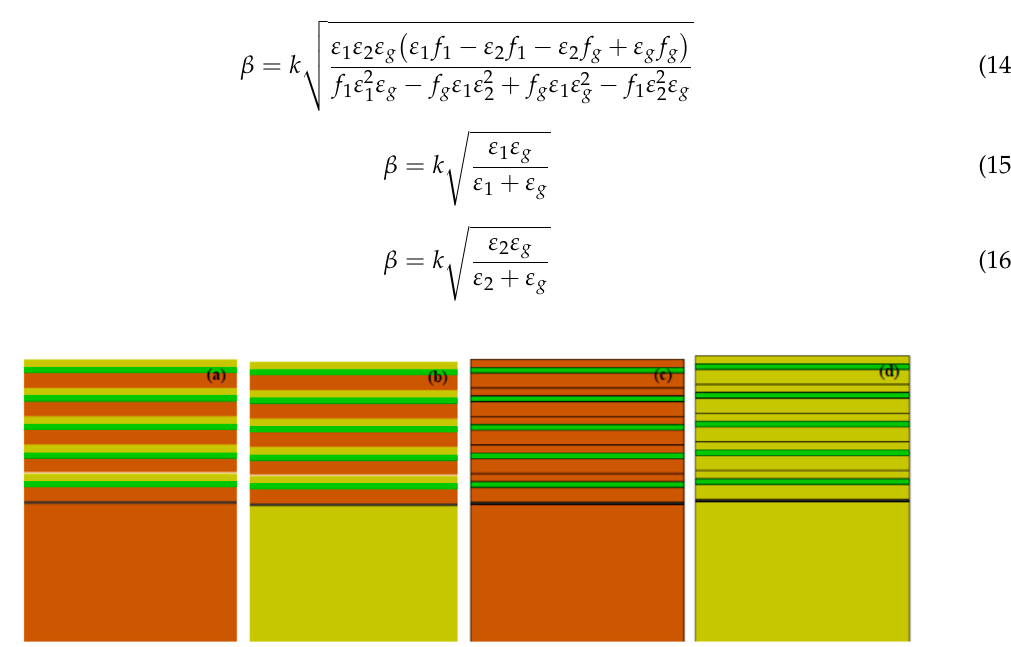
Figure 7. Schematic of graphene-dielectric multilayered MM. The figures correspond to ( a ) Equation (13), ( b ) Equation (14), ( c ) Equation (15), ( d ) Equation (16).